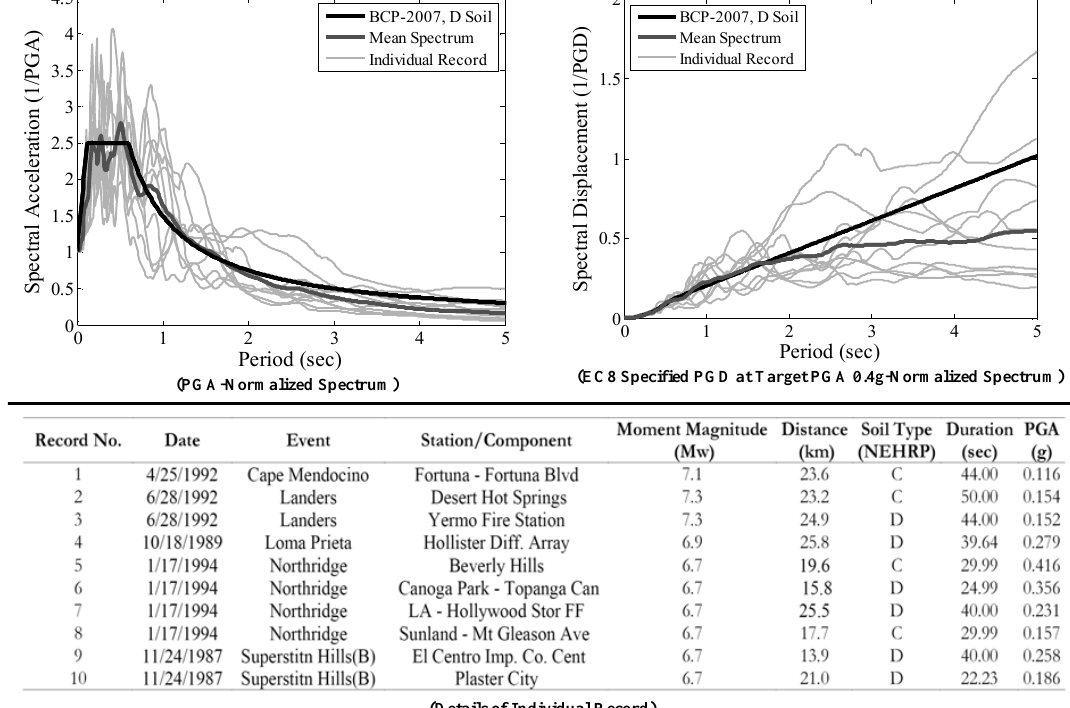
Figure 9 Characteristics of the accelerograms used in the present study. From left to right and top to bottom: acceleration response spectrum, displacement response spectrum and details of the individual record. Table 2 Damage scale considered for fragility functions derivation Limit States (LS) versus